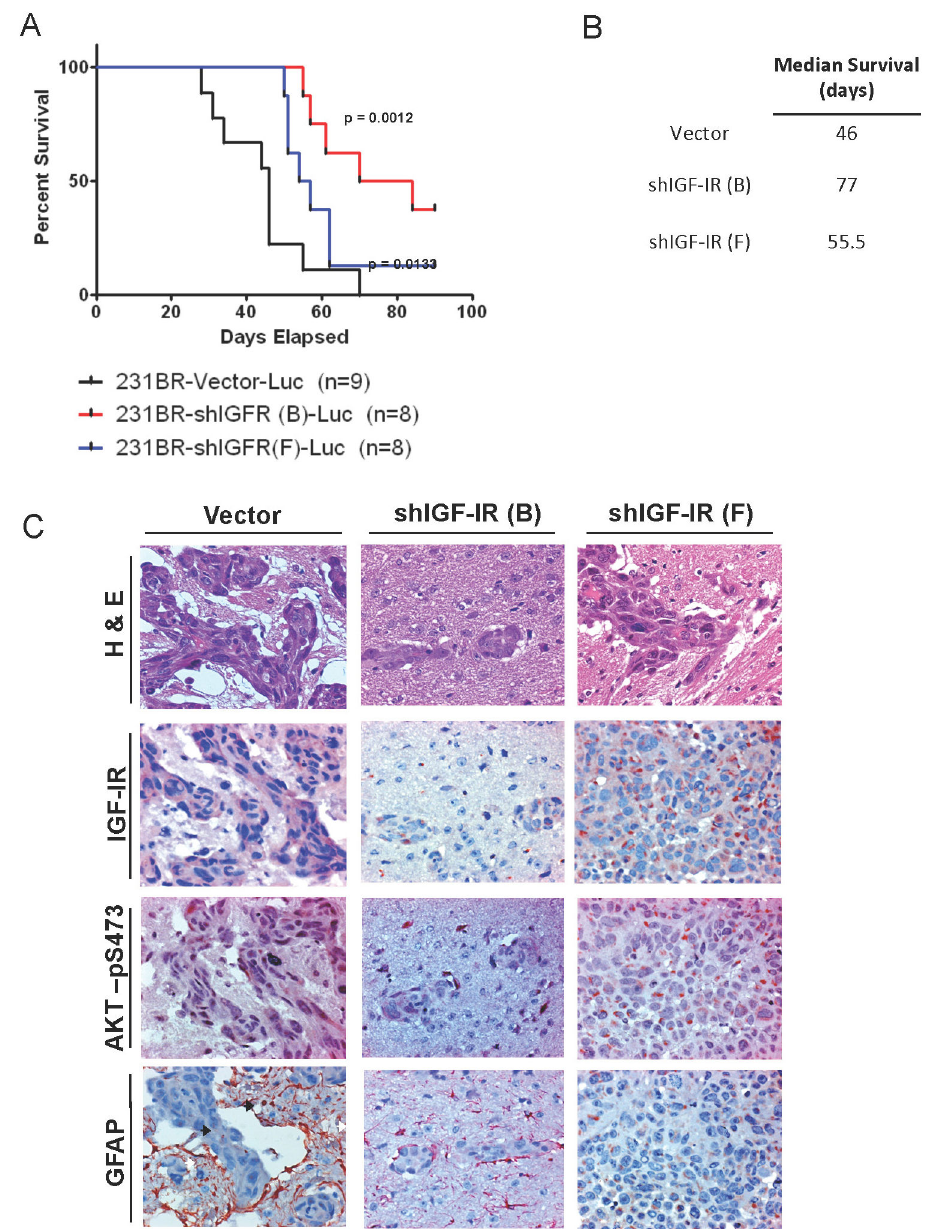
Figure 4. IGF-IR knockdown delays brain metastasis and prolongs survival in vivo . A, Survival curve of mice injected with 231Br cells stably expressing IGF-IR shRNA or vector shRNA. Mice were monitored weekly and sacrificed when moribund. shIGF- IR(B) and shIGF-IR(F) groups had significantly longer survival, p = 0.0012 and p = 0.0133, respectively. B, Median survival of each group from (A). C, H & E and IHC staining of representative brain metastases from each group. H&E panels: dark red = tumor tissue; blue = nucleus; light red = negative. IGF-IR and AKT-pSer473 panels: red = positive; blue = nucleus. GFAP: dark red/brown = positive; blue = nucleus; black arrows = tumor cells; white arrows = tumor-infiltrating astrocytes. Images were taken at 400x magnification.